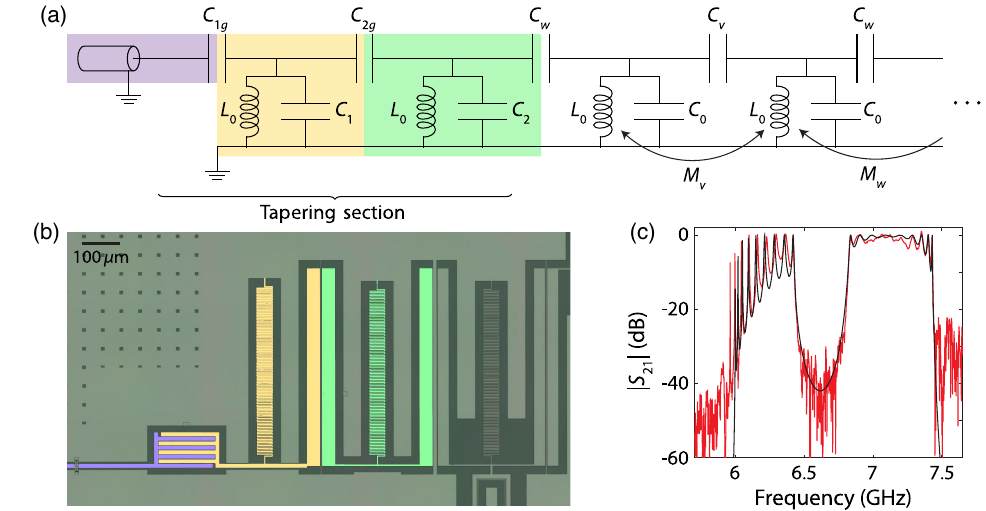
FIG. 11. Tapering section of device I. (a) The circuit diagram of the tapering section connecting a coplanar waveguide to the topological waveguide. The coplanar waveguide, first tapering resonator, and second tapering resonator are shaded in purple, yellow, and green, respectively. (b) Optical micrograph (false colored) of the tapering section on device I. The tapering section is colored in the same manner as the corresponding components in (a). (c) Red: measured waveguide transmission spectrum j S 21 j for device I. Black: fit to the data with parameters ð C ð C 1 ; C 2 Þ ¼ ð 128 . 2 ; 230 Þ fF, C 0 ¼ 250 fF, L 0 ¼ 1 . 9